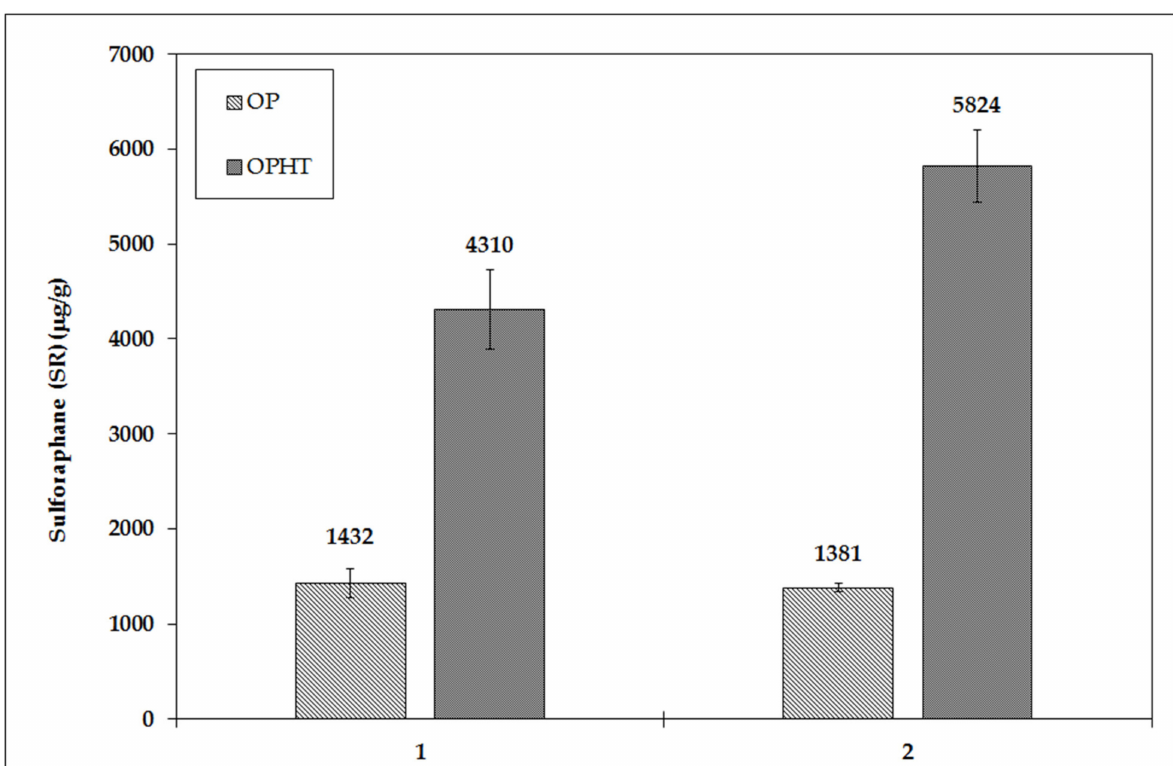
Figure 1. Effect of temperature on the preparation of the OP vs. OPHT lyophilized mixture on the SR content [ µ g/g d.w.]— Batch 1 on the left and Batch 2 on the